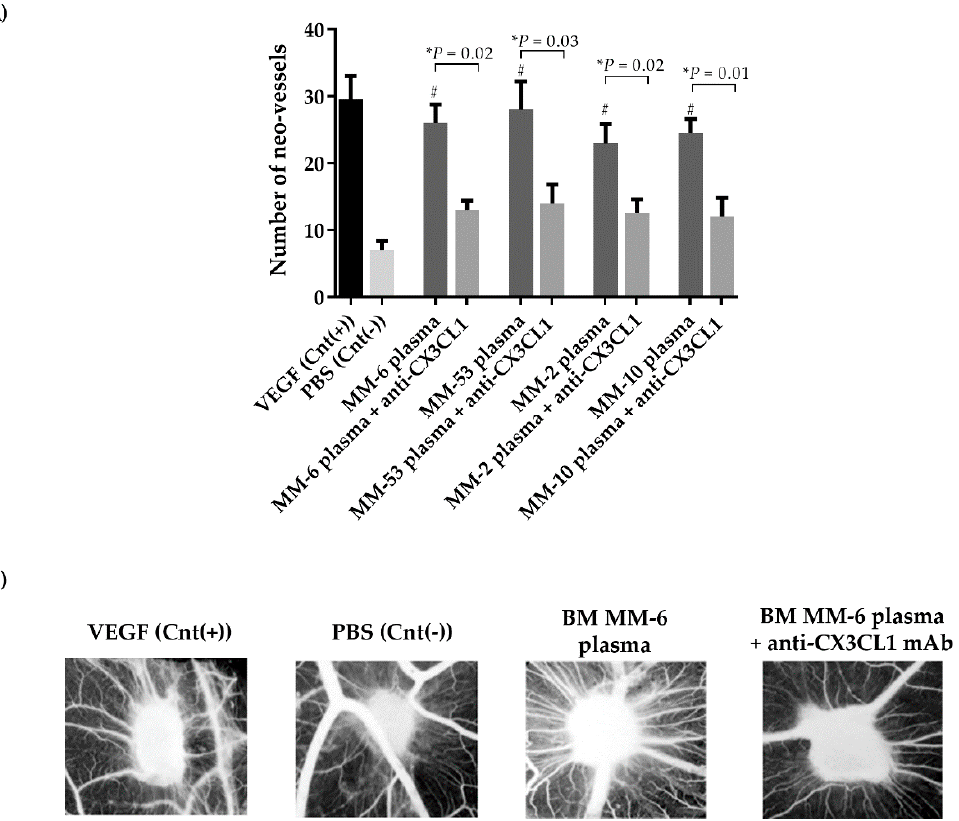
Figure 6. BM plasma from MM patients stimulates angiogenesis in vivo. The chorioallantoic membrane (CAM) assays were performed by treating the chicken chorioallantoic membrane for 12 days with BM plasma from four MM patients with or without anti-CX3CL1 (vascular endothelial growth factor (VEGF)) as positive control and phosphate-buffered saline (PBS) as negative control. ( A ) The histogram represents the mean ± SD of number of neo-vessels in CAM treated with BM plasma from four MM patients and with or without anti-CX3CL1 (0.3 µ g/mL). (BM plasma vs. negative control: # P < 0.05). # P values were calculated by one-tailed Student’s t -test. ( B ) Representative macroscopic pictures of gelatin implanted on the top of chick embryo chorioallantoic membrane of one experiment using BM plasma from MM-11 patient with or without anti-CX3CL1. Original magnification 50 ×.